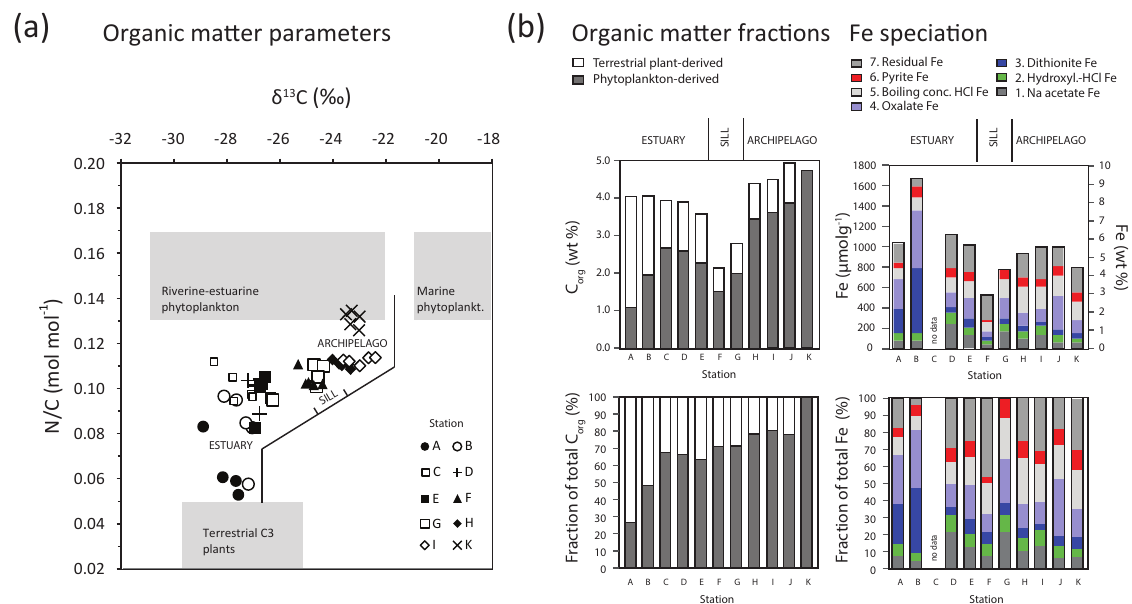
Figure 4. (a) Cross plot of molar N / C vs. δ 13 C of sedimentary organic matter along the Mustionjoki transect. Stations are indicated by the symbols. No isotope data was available for Station J. Four or five samples are plotted for each station, representing evenly spaced 2cm thick slices throughout a GEMAX ™ core of 30–60cm length (e.g., Station K: 0–2, 8.5–10.5, 17–19, 25.5–27.5, 34–36cm). (b) Organic matter fractions of the same sediment samples, derived from molar N / C ratios, assuming end-member values of N / C = 0.04 (terrestrially derived) and 0.13 (phytoplankton-derived). Mean values are reported of the four or five samples from each core; Operational Fe speciation of surface-sediment samples (0–2cm). No extraction data was available for Station